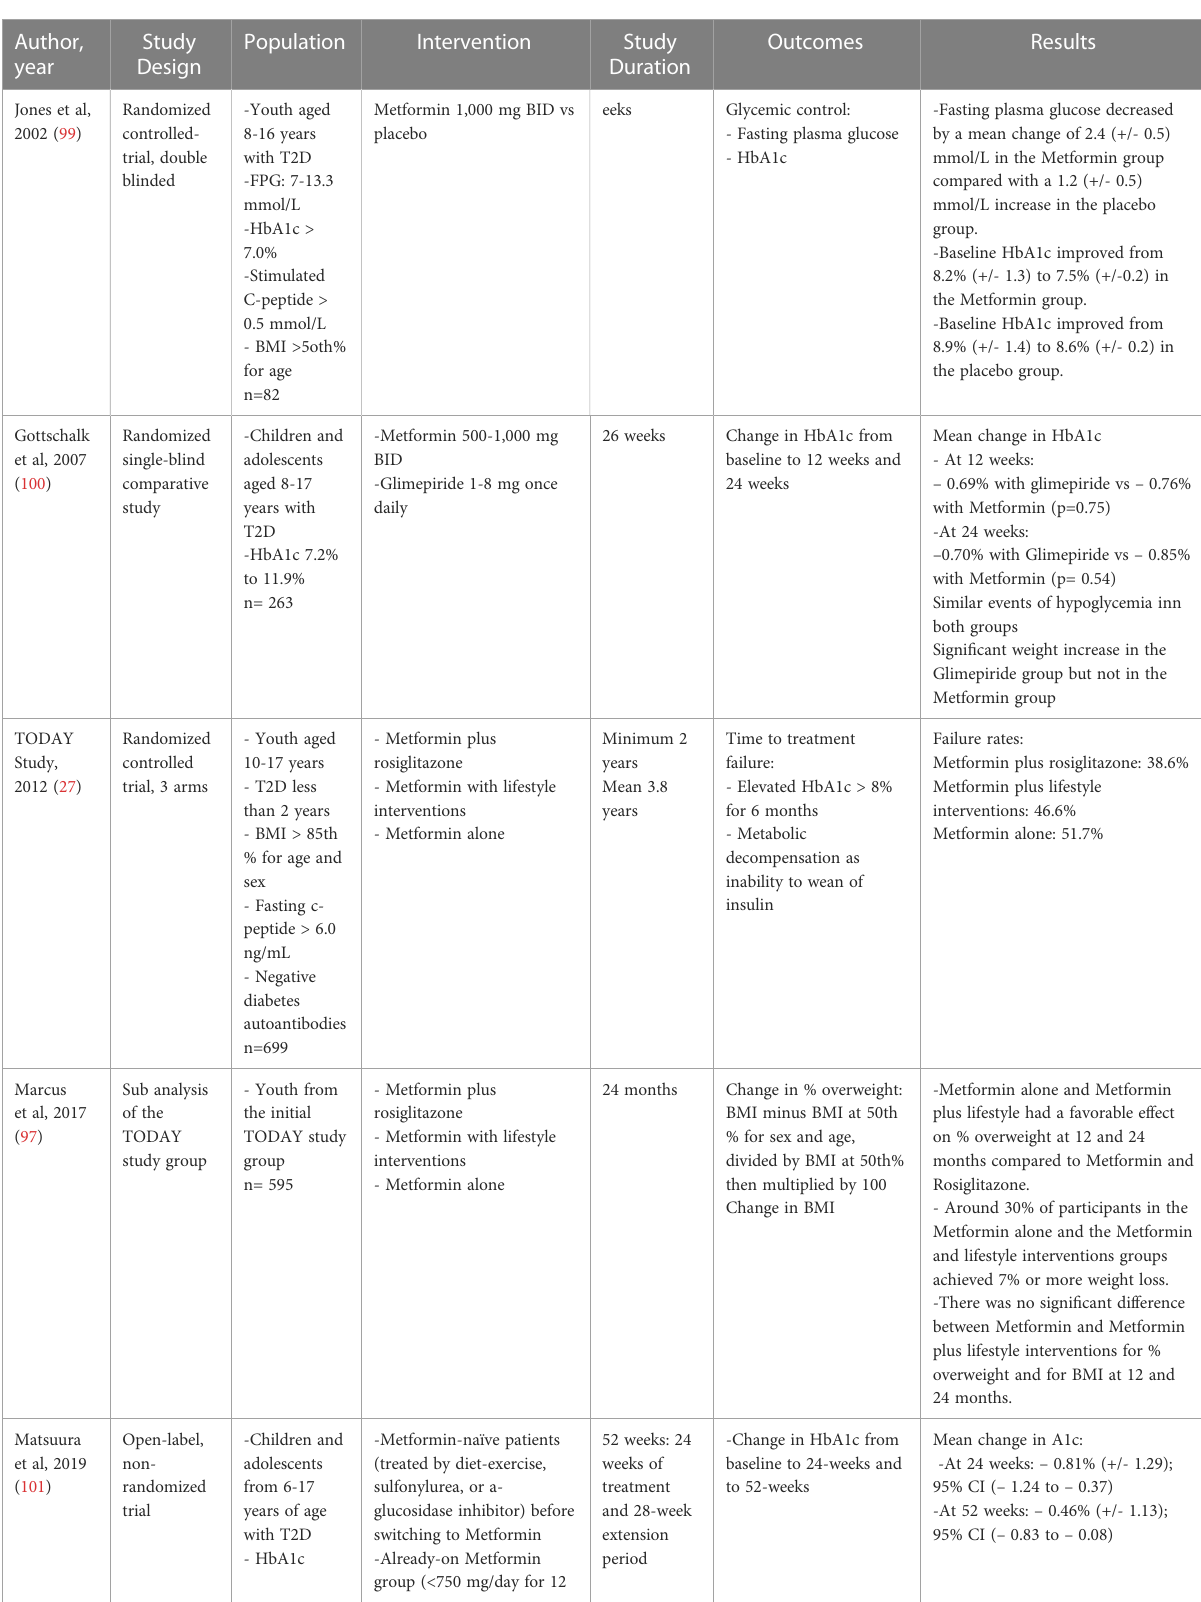
TABLE 1 Metformin Use in Children with type 2